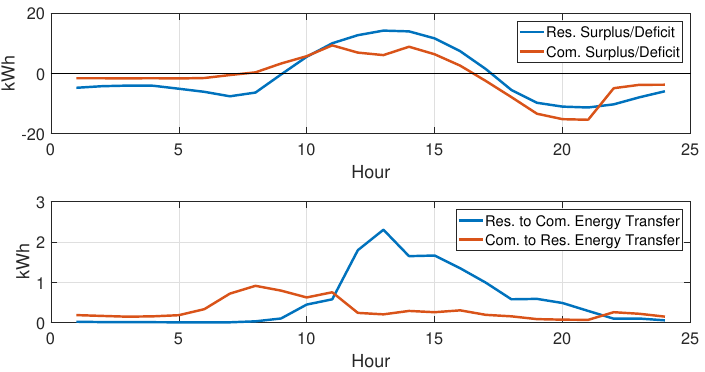
Figure 5. Monthly total energy transfers between the two prosumers.